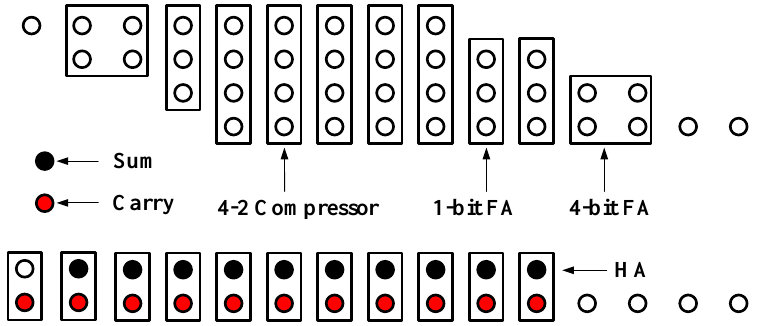
Figure 7. Proposed Wallace tree with two